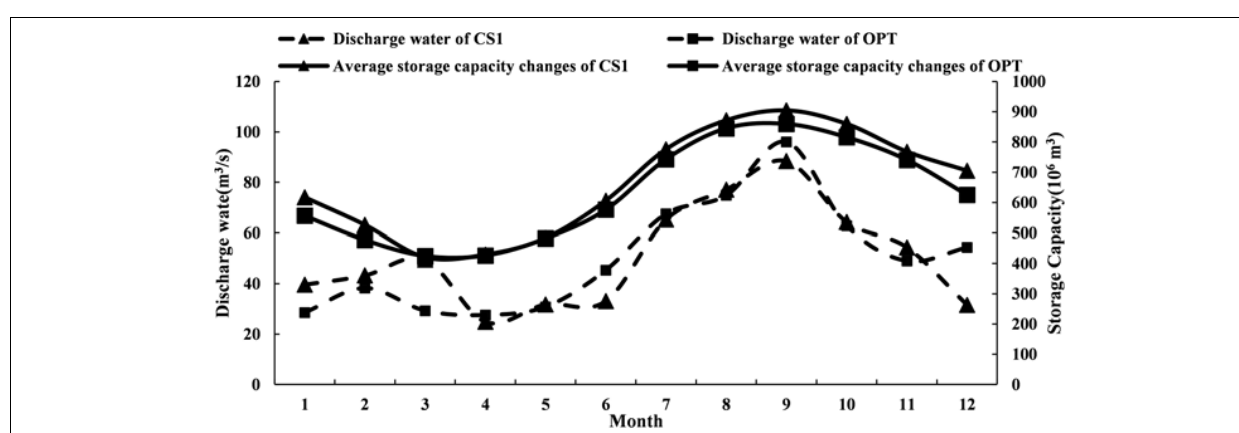
FIGURE 10 | Comparison of power generation scheduling results between OPT and CS1.